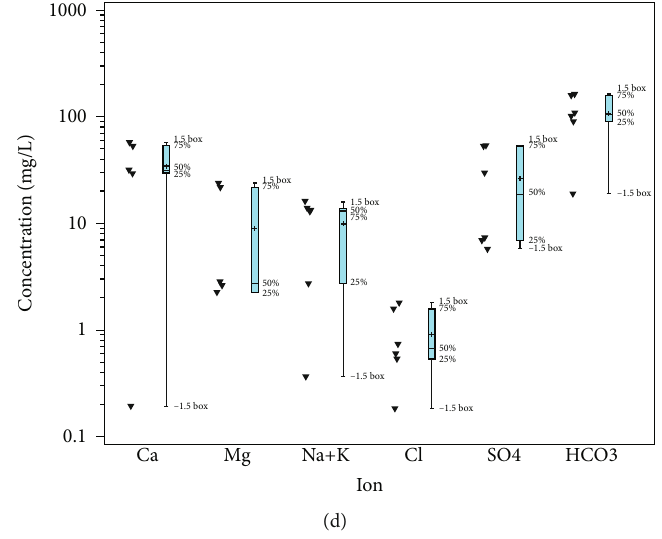
Figure 5: Major ion box diagram of the study